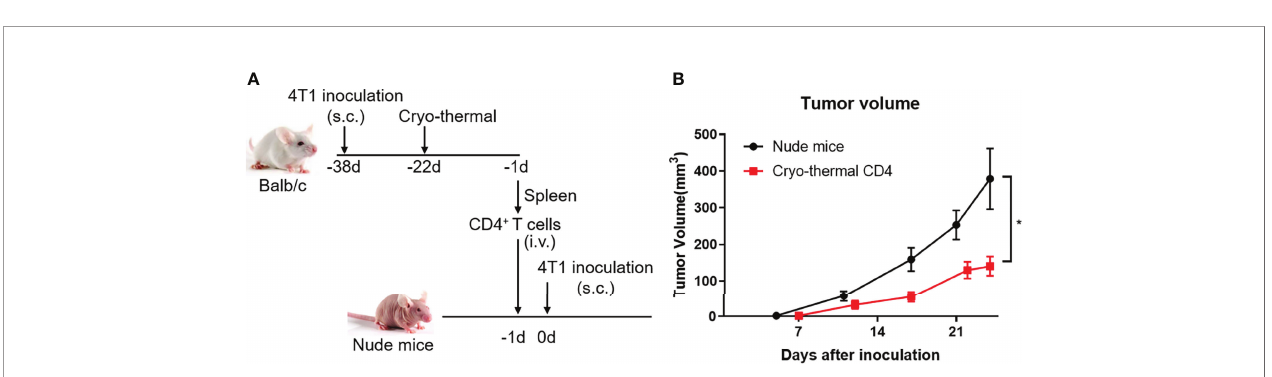
FIGURE 7 | Adoptive therapy of cryo-thermal CD4 + T cells. (A) Scheme of study design. Splenic CD4 + T cells were separated on day 21 after cryo-thermal therapy by MACS and were adoptive transferred into nude mice (1.5 million cells in 100 m L PBS per mice, i.v.). After 24 hours, the nude mice were inoculated with 50 thousand of 4T1 cells subcutaneously. The tumor volume was measured and calculated following formula: V (cm 3 ) = p × L (major axis) × W (minor axis) × H (vertical axis)/6. (B) Growth kinetics of a 4T1 breast cancer tumor model in nude mice as described. *p < 0.05. n =6 for each group.